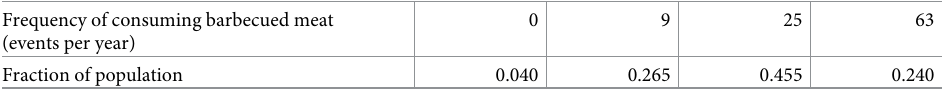
Derived from consumer-surveys in Denmark [26,